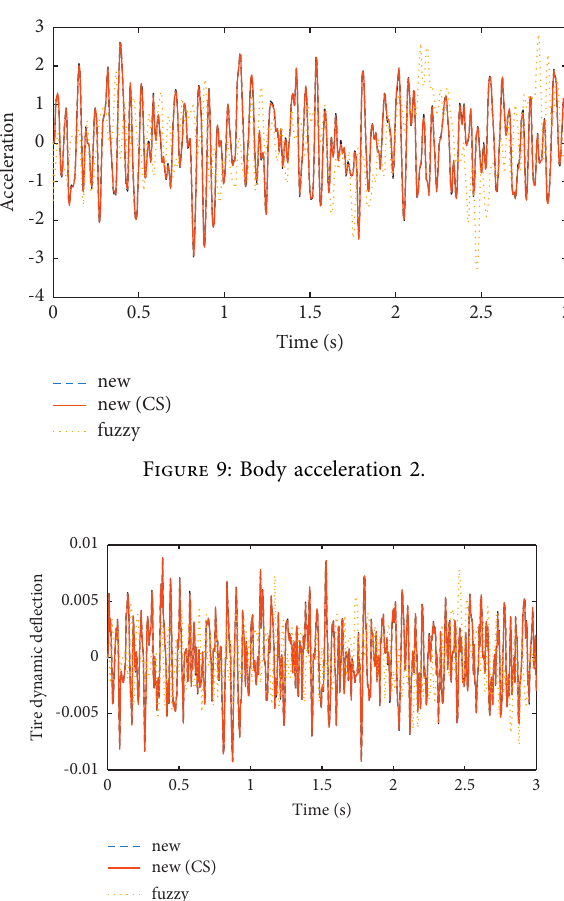
Figure 10: Tire dynamic displacement 2.